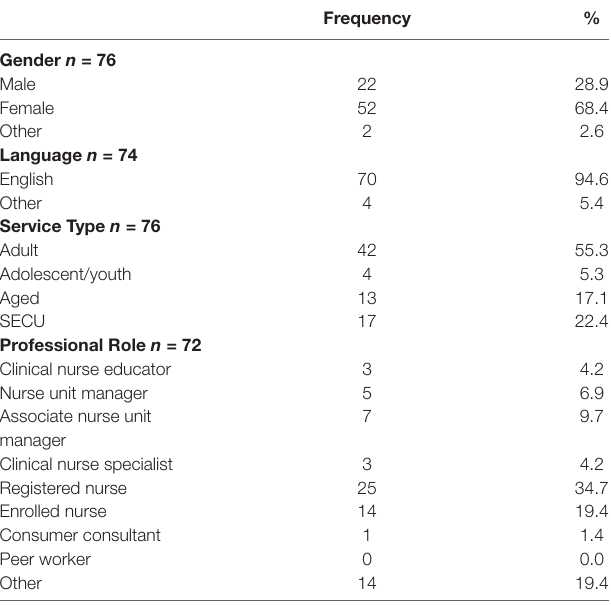
TABLE 2 | Participant